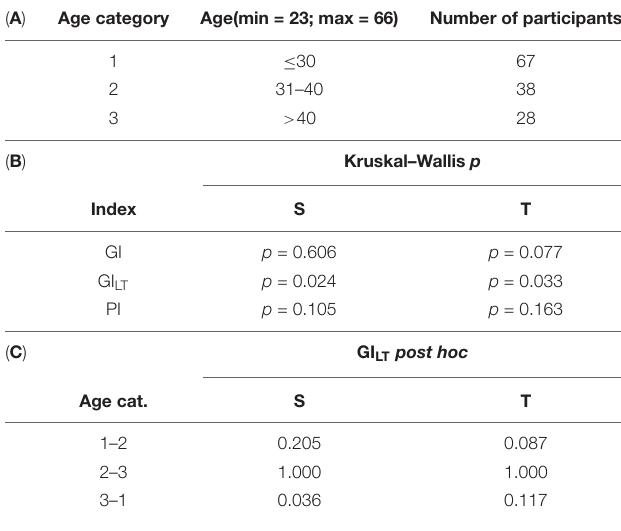
TABLE 4 | Age analysis of HRA indices (GI, GI LT , and PI): age categorization ( A ); analysis of each parameter between age groups in supine and tilt ( B ); and post hoc comparison of GI LT in supine and tilt ( C